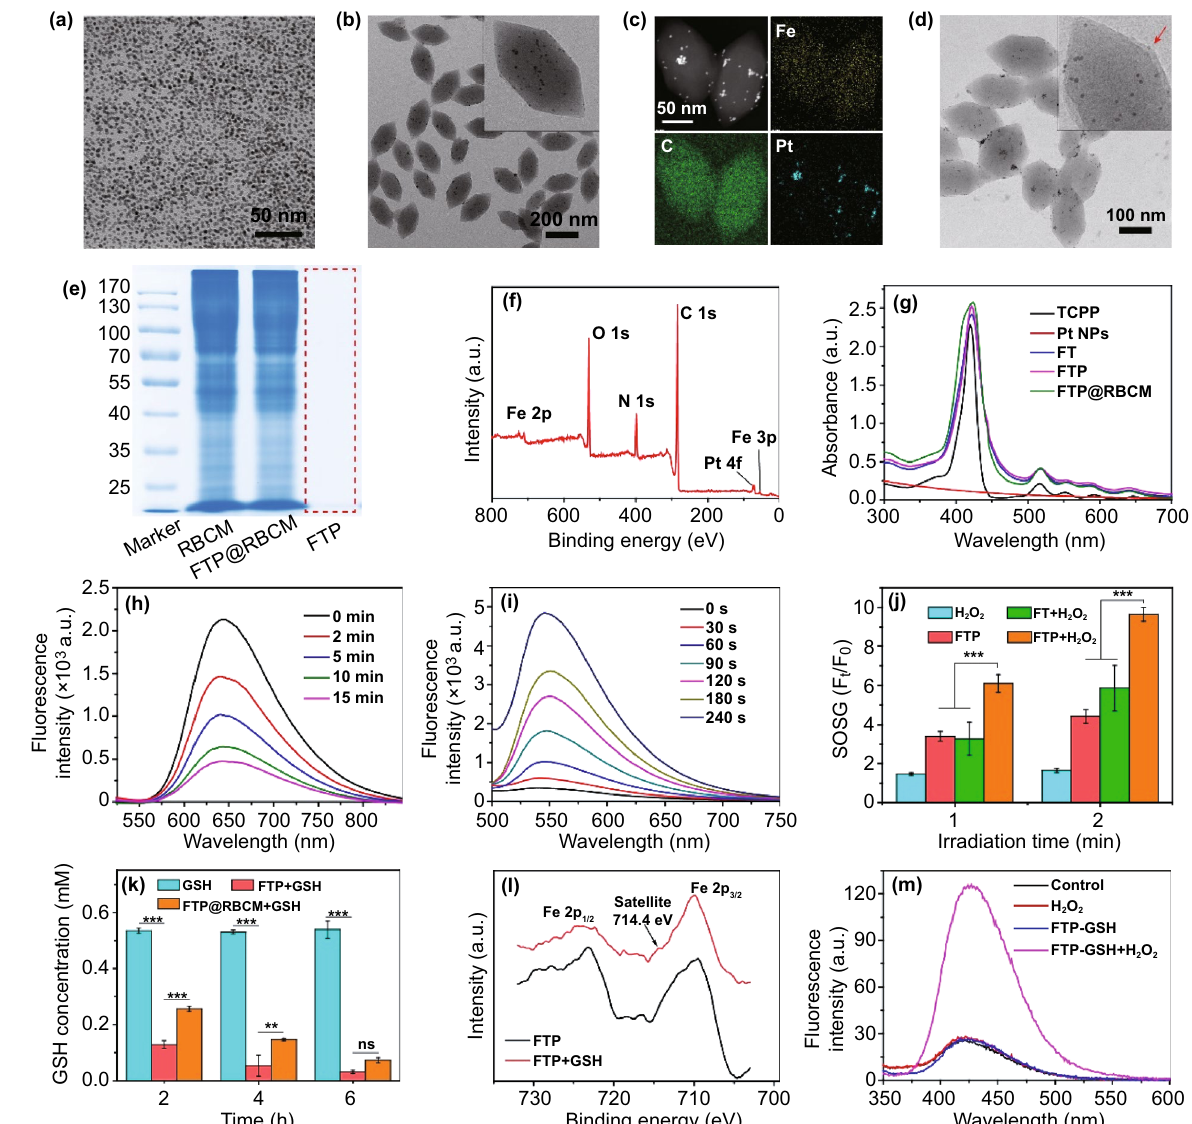
Fig. 1 TEM image of a Pt nanoparticles and b FTP. c TEM mapping of FTP. d TEM image of FTP@RBCM. e SDS-PEGA protein analysis of RBCM, FTP, and FTP@RBCM. f XPS spectrum of FTP@RBCM. g UV–Vis spectra. h Fluorescence spectrum of [Ru(dpp) 3 ]Cl 2 incubated with FTP and H 2 O 2 . i Fluorescence spectrum of SOSG in the presence of FTP under 670 nm laser irradiation. j Relative fluorescence intensity of SOSG at 530 nm ( n = 3). k GSH concentration after different treatments ( n = 3). l XPS spectra of Fe 2p in FTP. m Fluorescence intensity of the solution containing TPA with different